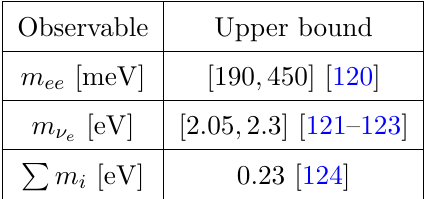
Table 5. The current experimental 90 % C.L. upper bounds for relevant charged lepton (cid:13)avor violating processes and electric and magnetic dipole moments.